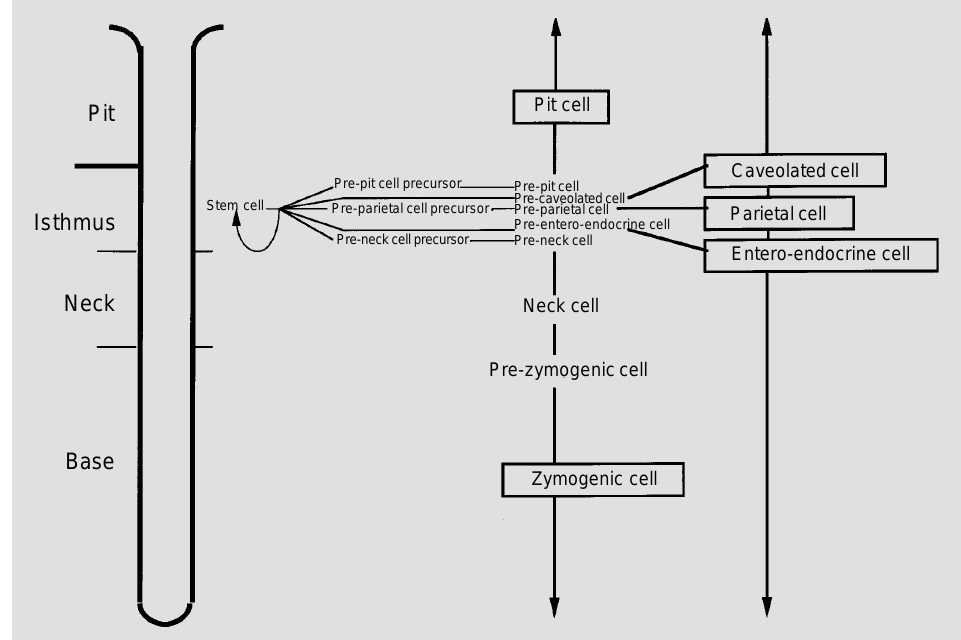
Figure 1 - Cell lineage relation- ships in the pit-gland unit of the corpus region of the mouse stomach. In the isthmus region of the gastric gland, the undif- ferentiated granule-free cell is the multipotent stem cell that divides to replace itself and to produce five lineage precursors. 1) Pre-pit cell precursors give rise to pre-pit cells that migrate upward to the pit while differen- tiating into pit cells. 2) Pre-pari- etal cell precursors give rise to pre-parietal cells which com- plete their differentiation into parietal cells in the isthmus and then undergo bipolar migration to the pit as well as to the neck/ base regions. 3) Pre-neck cell precursors give rise to pre-neck cells that migrate downward into the neck while differentiat- ing into neck cells which then transform into zymogenic cells in the base via a pre-zymogenic stage. 4) Pre-caveolated cells transform into caveolated cells in the isthmus and then undergo bipolar migration. 5) Pre-entero- endocrine cells differentiate into entero-endocrine cells in the isthmus and then undergo bipo- lar